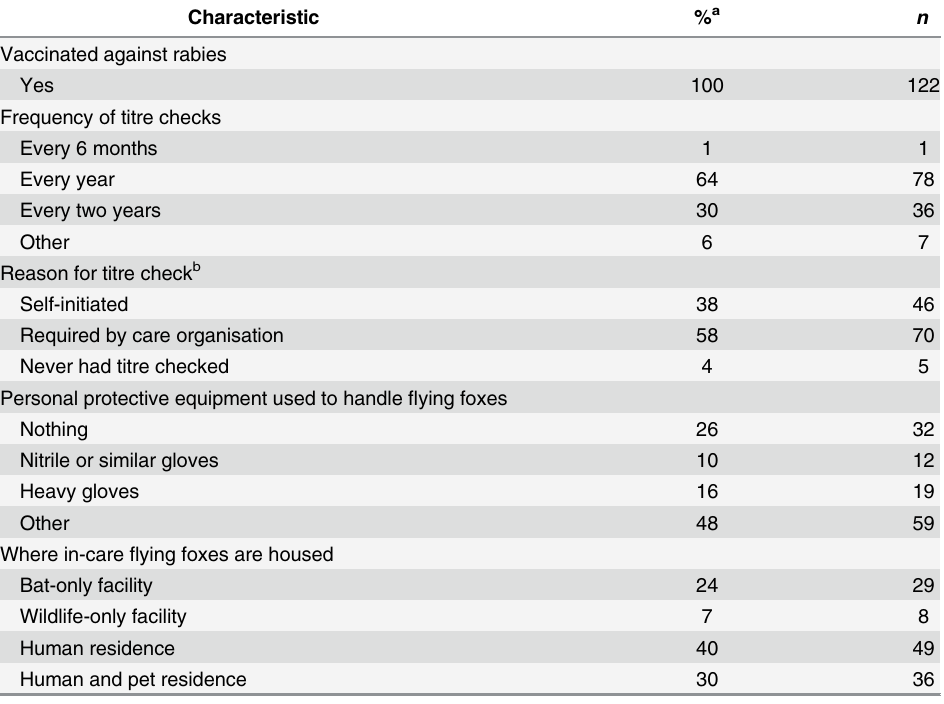
Table 3. Reported safety practices of 122 Australian flying fox rehabilitators, 2014 Characteristic % a n Vaccinated against rabies